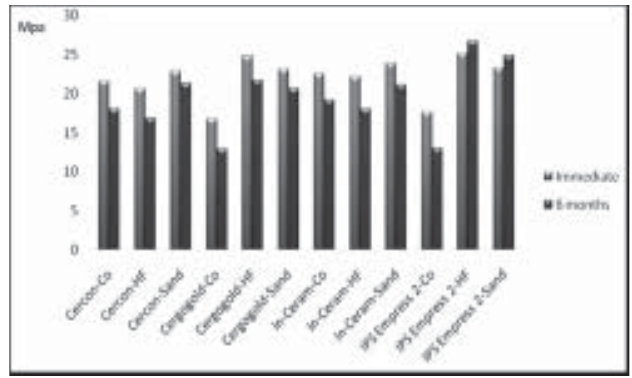
Fig 1. Shear bond strength (MPa) of ceramics in accordance with surface treatment and storage time.